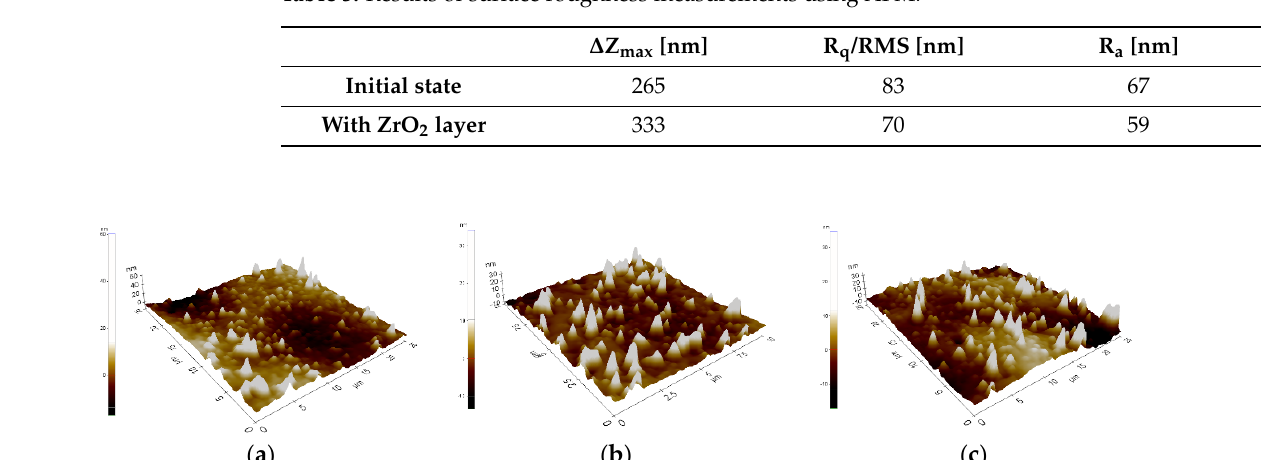
Table 3. Results of surface roughness measurements using AFM.